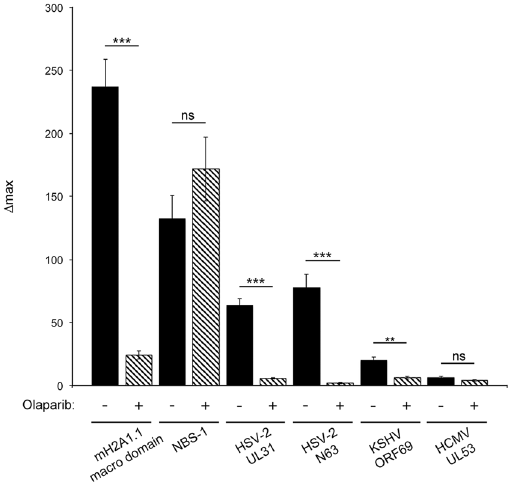
Figure 9. UL31 recruitment to sites of laser microirradiation requires PARP1/2 activity. HeLa 0.1% DMSO (vehicle) or 10 nM olaparib, a PARP1/2 inhibitor, one hour prior to imaging. Δ max values of 0.1% DMSO ( − ) and 10 nM olaparib treated ( + ) cells expressing the indicated proteins was determined as described above in Fig. 5. n ≥ 6 cells/experiment in two to four independent experiments for each construct analyzed. Error bars represent standard error of the mean. Using an unpaired t test the Δ max of DMSO treated cells was compared to olaparib treated cells (ns = not significant, ** p < 0.01, *** p <